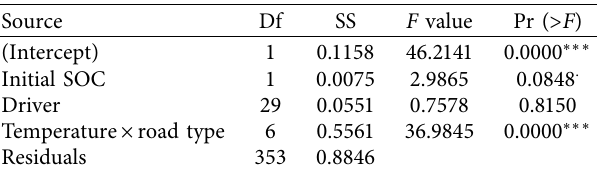
Table 8: ANOVA of the road type analysis with interaction effect of road type and